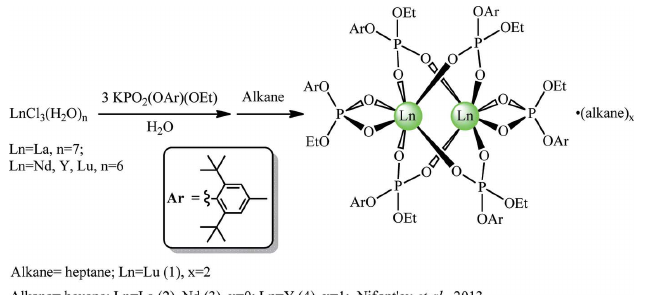
Figure 1 Synthesis of {Ln 2 [(2,6- t Bu 2 -4-MeC 6 H 2 -O)(EtO)PO 2 ] 6 } 1 .